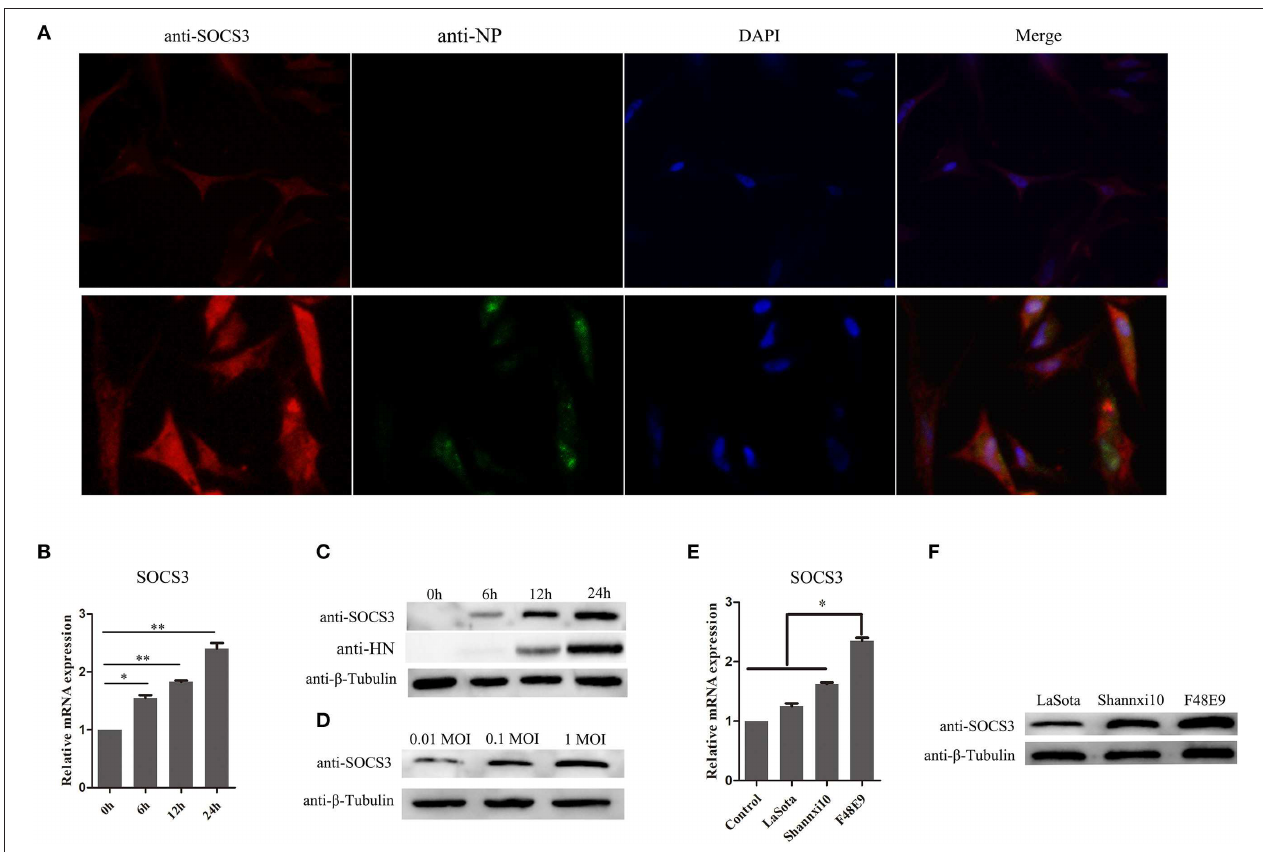
FIGURE 2 | NDV infection increases the expression of SOCS3. (A) CEF cells were infected with NDV (0.1 MOI). IFA was performed to detect the expression of SOCS3 and NDV 24 hpi. (B,C) CEF cells were infected with NDV (0.1 MOI), cells were harvested and qRT-PCR and WB were performed to test the expression of SOCS3 at different times. (D) WB was performed to detect the protein expression of SOCS3 at 24h post different MOI NDV (0.01 MOI, 0.1 MOI, 1 MOI) infection. (E,F) CEF cells were infected with different virulence NDV. At 24 hpi, cells were harvested and qRT-PCR and WB were performed to test the expression of SOCS3. Data presented are from three independent experiments and presented as mean ± SD. * P < 0.05; ** P <